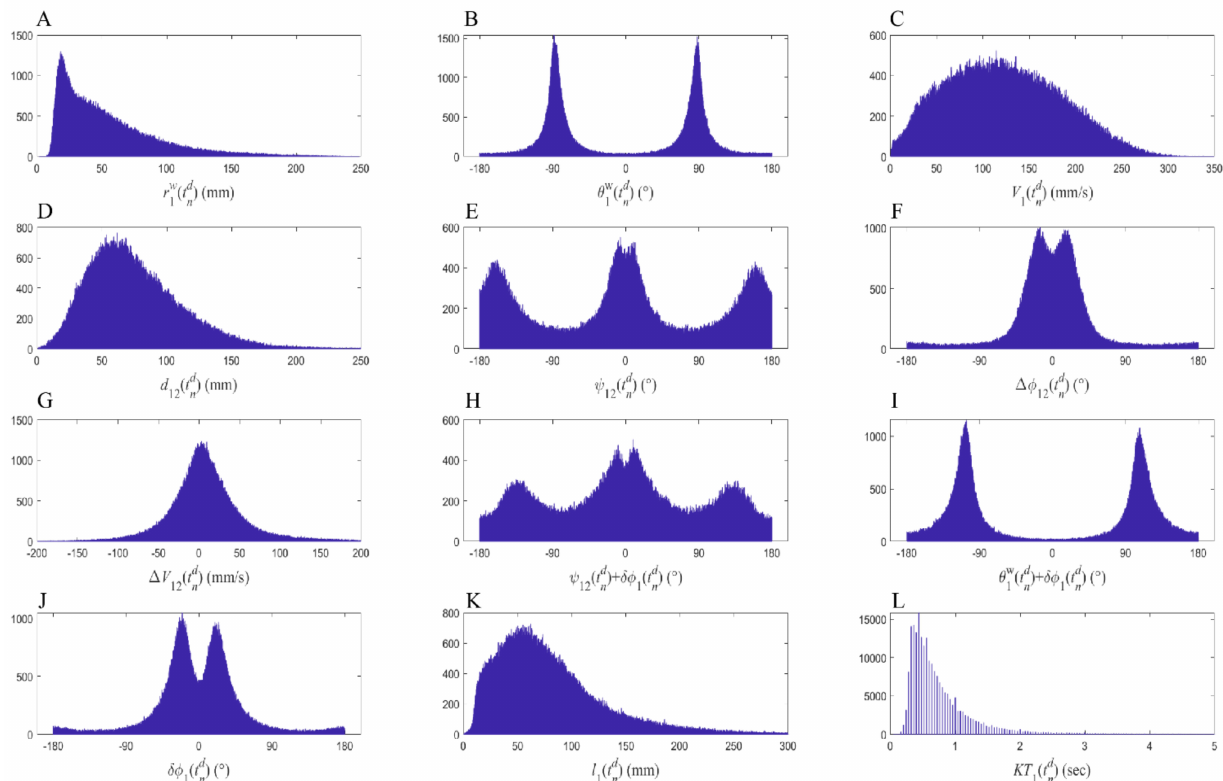
Figure 2. The histogram of the measurement value and decision value of the two–fish experiment. For local information of focal fish i at decision time t d n , the static information includes: ( A ) the distance to the wall r W ( t d ) and ( C ) the average speed of the focal fish V angle to the wall θ W n i includes ( D ) the distance to the neighbor d ij ( t d n ) , ( E ) the viewing angle of neighbor ψ ij ( t d n ) , ( F ) relative orientation angle to the neighbor ∆ φ ij ( t d n ) , and ( G ) the average relative speed with the neighbor (cid:52) V ij ( t d n ) . ( H ) The viewing angle of neighbor ψ ij ( t d n ) + δφ i ( t d n ) after heading changing of the focal fish. ( I ) The angle to the wall θ W of the focal fish. The decision of the focal fish consists of three parts, which are ( J ) the heading changing angle δφ i ( t d n ) , ( K ) the kick length l i ( t d n ) and ( L ) the duration time of the kick KT i ( t d n )